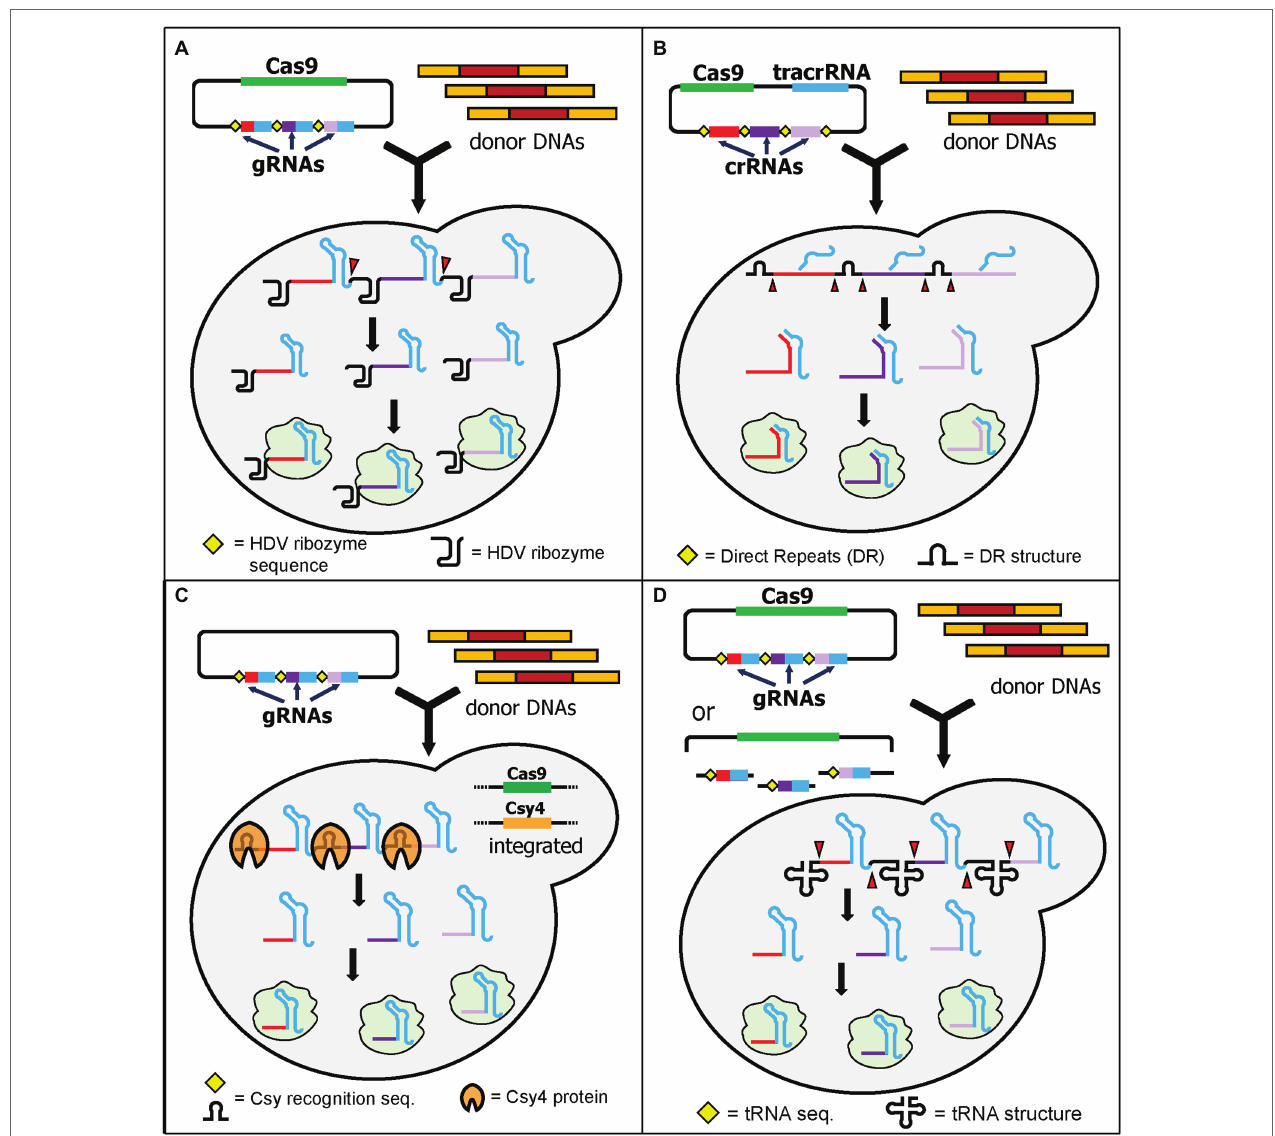
FIGURE 2 | Schematic diagram of multiplex gene editing using multiple gRNAs in a single gRNA cassette with RNA cleaving mechanisms. (A) HDV ribozyme self- cleaving mechanism by Ryan et al. After transcription, the HDV ribozyme cuts at its 5 ' end (red triangles) to produce multiple gRNAs. (B) HI-CRISPR by Bao et al. utilized the direct repeats (DR) from S. pyogenes . When it is expressed in yeast, the DR will be cleaved (red triangles) by unknown yeast endogenous nucleases and/ or RNases, producing multiple gRNAs. Note that the tracrRNA will bind to the structural part of the crRNA before cleaving. (C) Csy4 endoribonuclease from Pseudomonas aeruginosa can be utilized by providing recognition sites between gRNAs. Csy4 and Cas9 were integrated into the yeast genome. Upon transcription, Csy4 recognizes and cleaves the recognition sites. (D) Yeast endogenous tRNA can be provided in between the gRNAs. Either fully assembled plasmids or linear plasmids with gRNA fragments can be transformed. The linear plasmid can be assembled in vivo using yeast DNA assembly. Upon transcription, the tRNAs are cleaved, resulting in multiple gRNAs (red